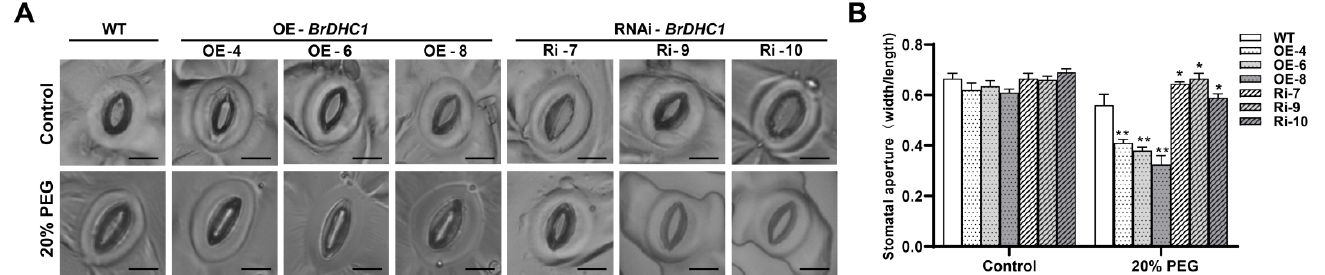
Figure 4. Stomata morphology analysis of different lines under drought treatment. ( A ) Leaf stomata morphology of WT, OE- BrDHC1 , and RNAi- BrDHC1 plants under normal and 20% PEG treatment (n = 10). ( B ) Statistical analysis of the width to length ratio of stomata from WT, OE- BrDHC1 , and RNAi- BrDHC1 transgenic plants under normal and drought stress treatment (data represent the means ± SD of 3 replicates; Student’s t test was performed to compare differences between the wild-type and the transgenic plants under 20% PEG treatment, along with one-way analysis of variance (ANOVA), * p value < 0.05, ** p value < 0.01).